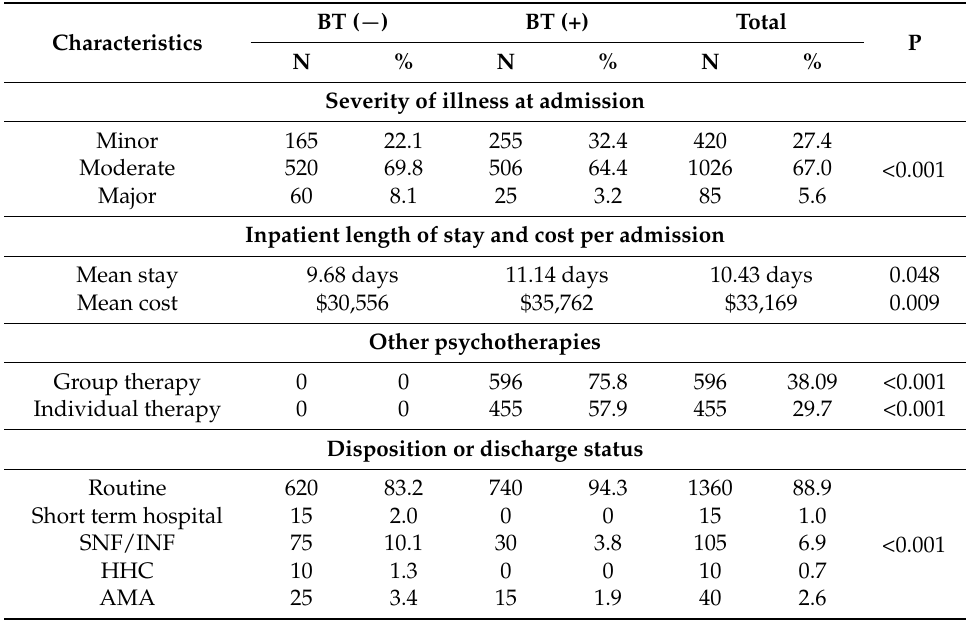
Table 2. Inpatient Outcomes distribution of patients by